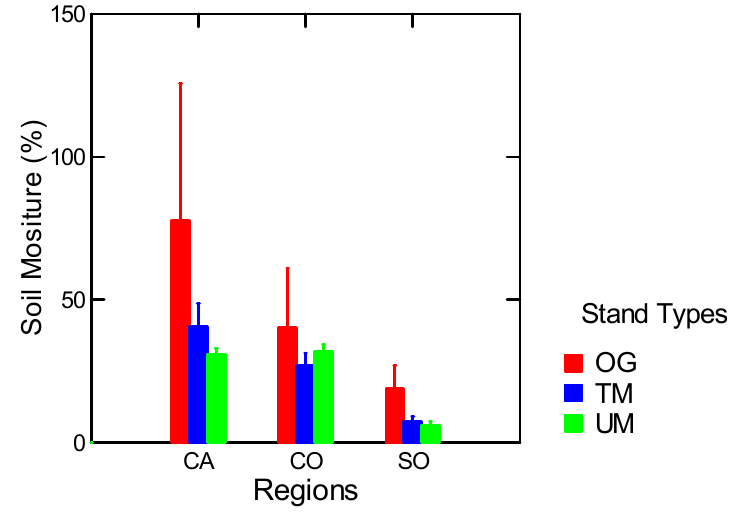
Figure 3. Percent soil moisture in the top 10 cm of mineral soil, by stand type and region. CA = Cascades; CO = Coast Range; SO = Siskiyous; Bars = standard errors.